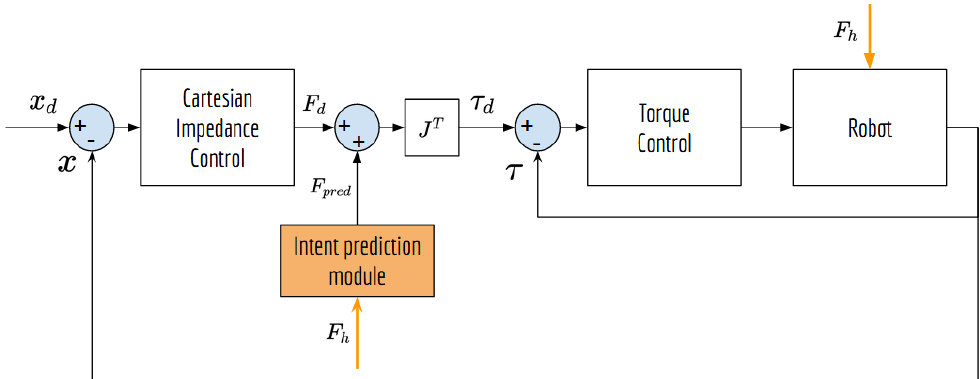
Figure 1. Impedance controller diagram with amplification module for the force amplification strategy.